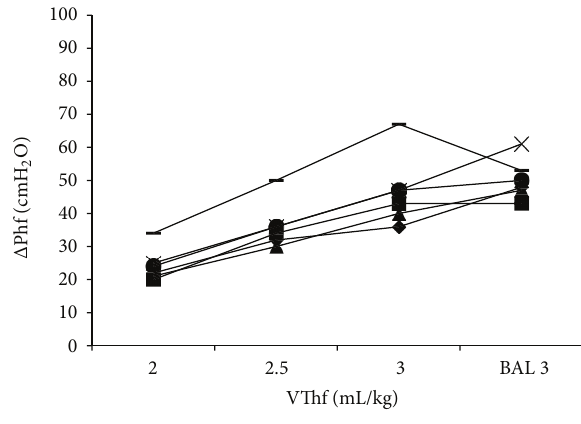
Figure 3: Δ Phf determined at different VThf before and after surfactant depletion by bronchoalveolar lavage